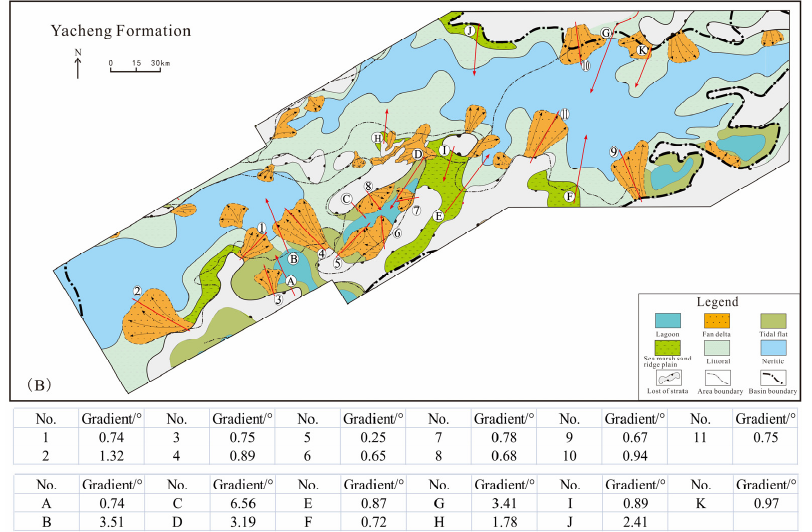
Figure 10. The slope gradient of the paleogeomorphology and the deltas at the edge of the basin (“A” and “1” are the line numbers chosen to compute the slope gradient of the paleogeomorphology and the delta gradient, respectively. ( A ): The sedimentary facies of the third-member of Lingshui Formation; ( B ): The sedimentary facies of Yacheng Formation. (Figure A and the relevant data were modified after Song et al., 2020a [37].)